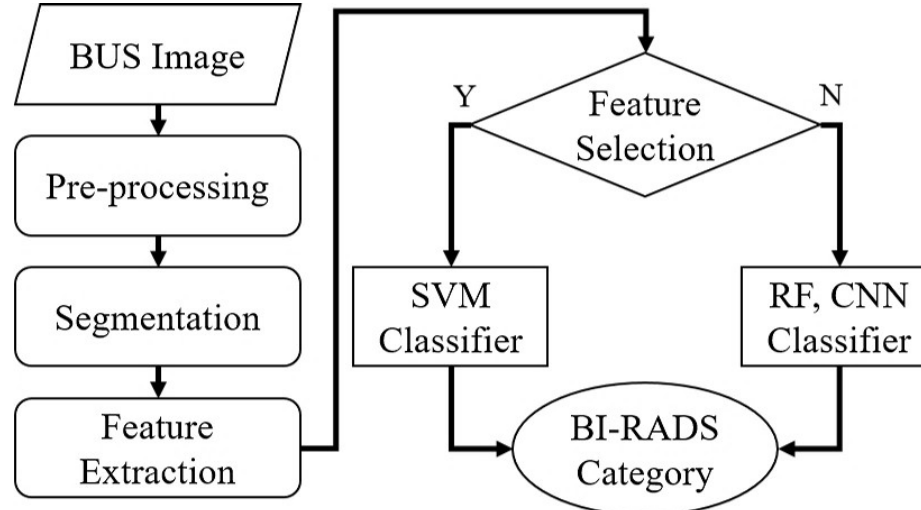
Figure 2. Flowchart of the BI-RADS category identification